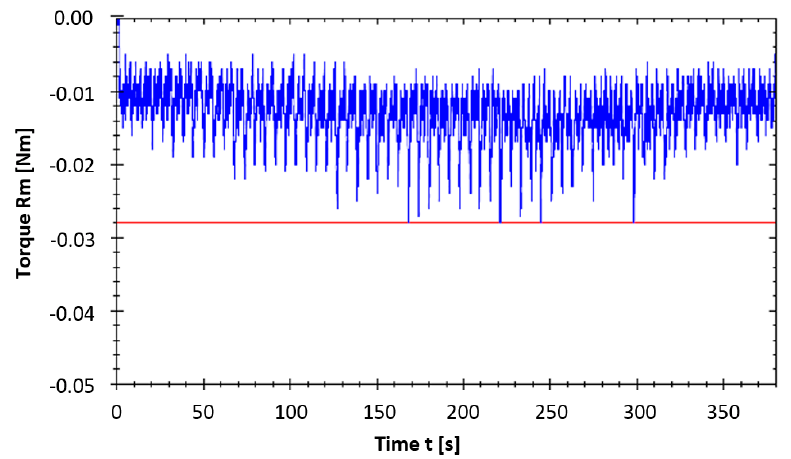
Figure 12. Starting torque BS TS 050-63, s/n.1901—CCW direction (after the trial run).